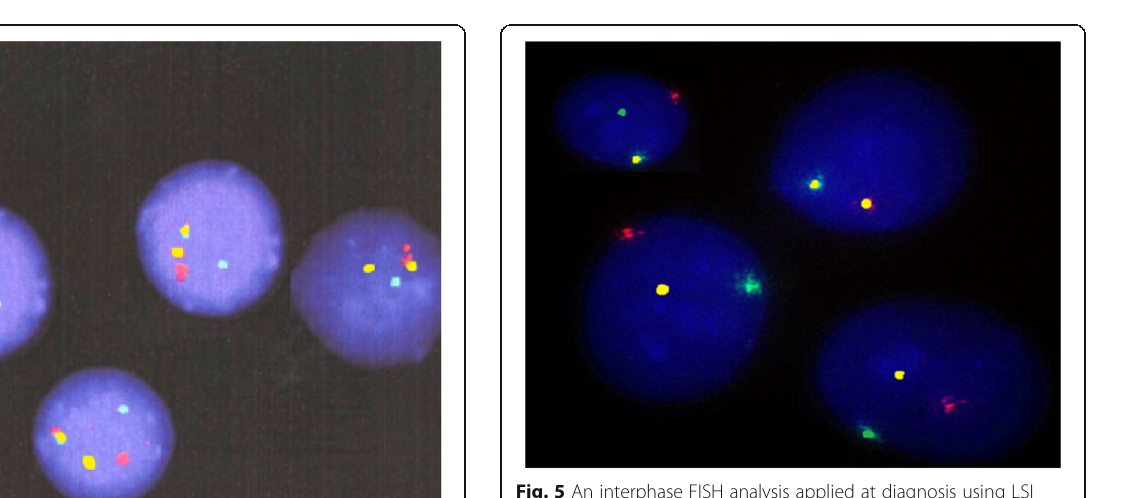
Fig. 5 An interphase FISH analysis applied at diagnosis using LSI break apart MLL probe positive for 11q23 rearrangements, 1 yellow signal (juxtaposed red and green) represents the normal copy of MLL gene in addition to one green signal and one red signal represent the rearranged copy of MLL (11q23